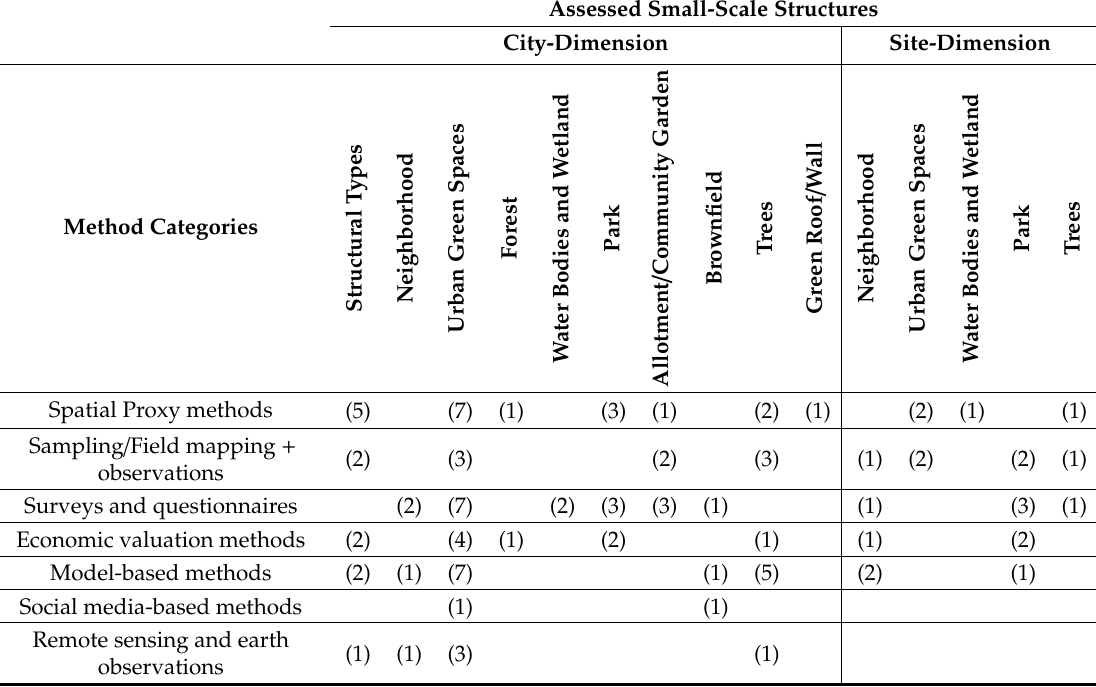
Table 4. Numbers of methods identified in the reviewed articles to assess green infrastructure types. The figures in brackets show how often a method was applied to the corresponding structure type. Since multiple methods were used in some articles, the sum of methods is higher than the actual number of